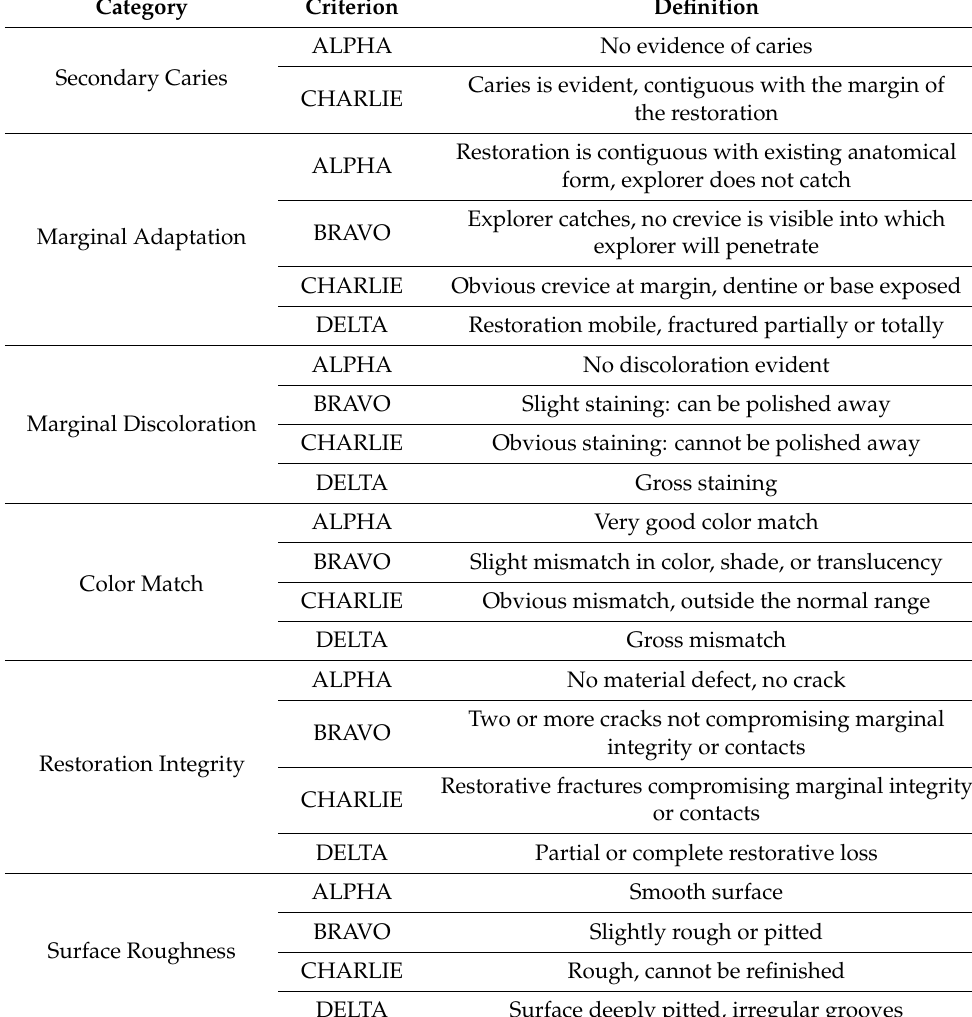
Table 2. Modified United States Public Health Service criteria used for restoration